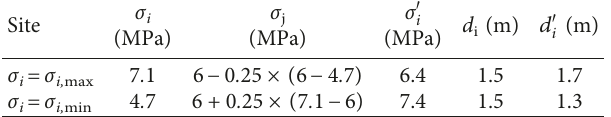
Table 7: Details of the calculation progress.